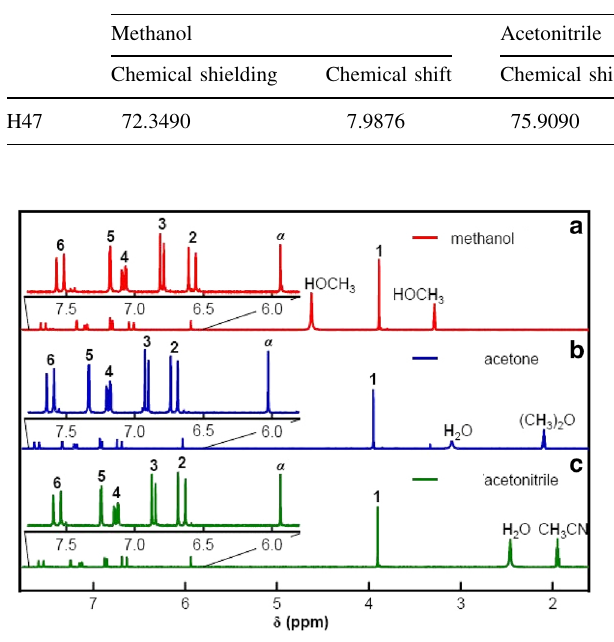
Fig. 7 NMR spectra in a methanol, b acetone, and c acetonitrile